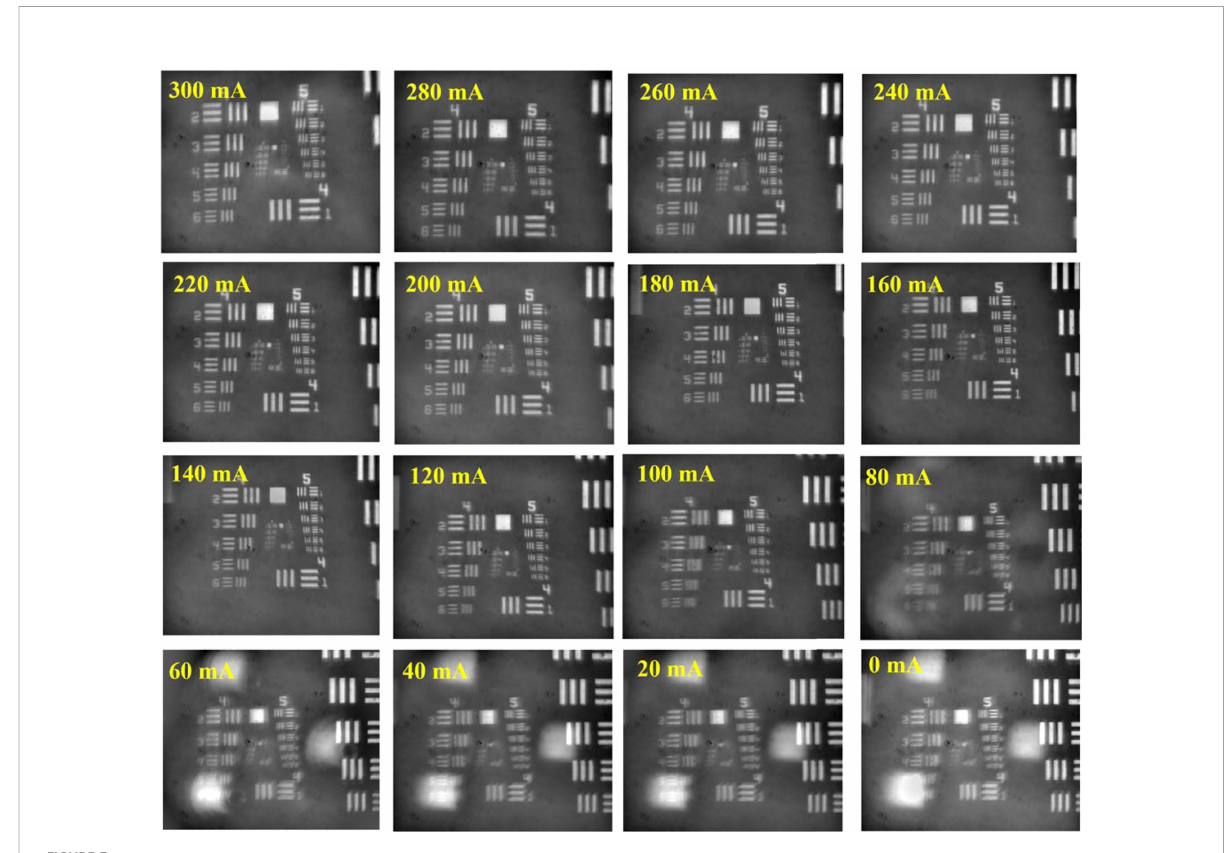
FIGURE 3 The imaging results of MICROcean under different drive